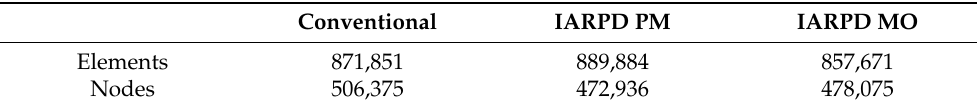
Table 2. Description of the total number of elements and nodes per model.